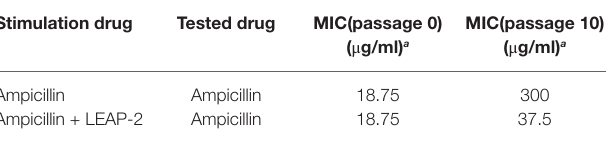
TABLE 5 | Topmouth culter LEAP-2 delayed the ampicillin-induced drug resistance against V. parahaemolyticus .